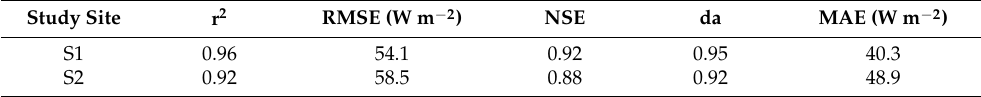
Table 2. Performance of measured and modeled ET data collected from two study sites of hazelnut. Study Site